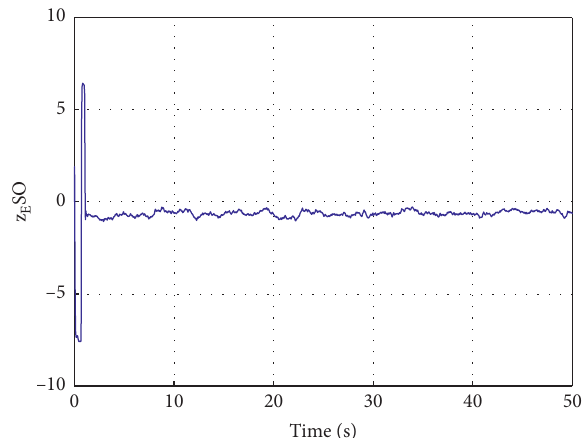
Figure 15: Disturbance estimation of z channel under wind condition.